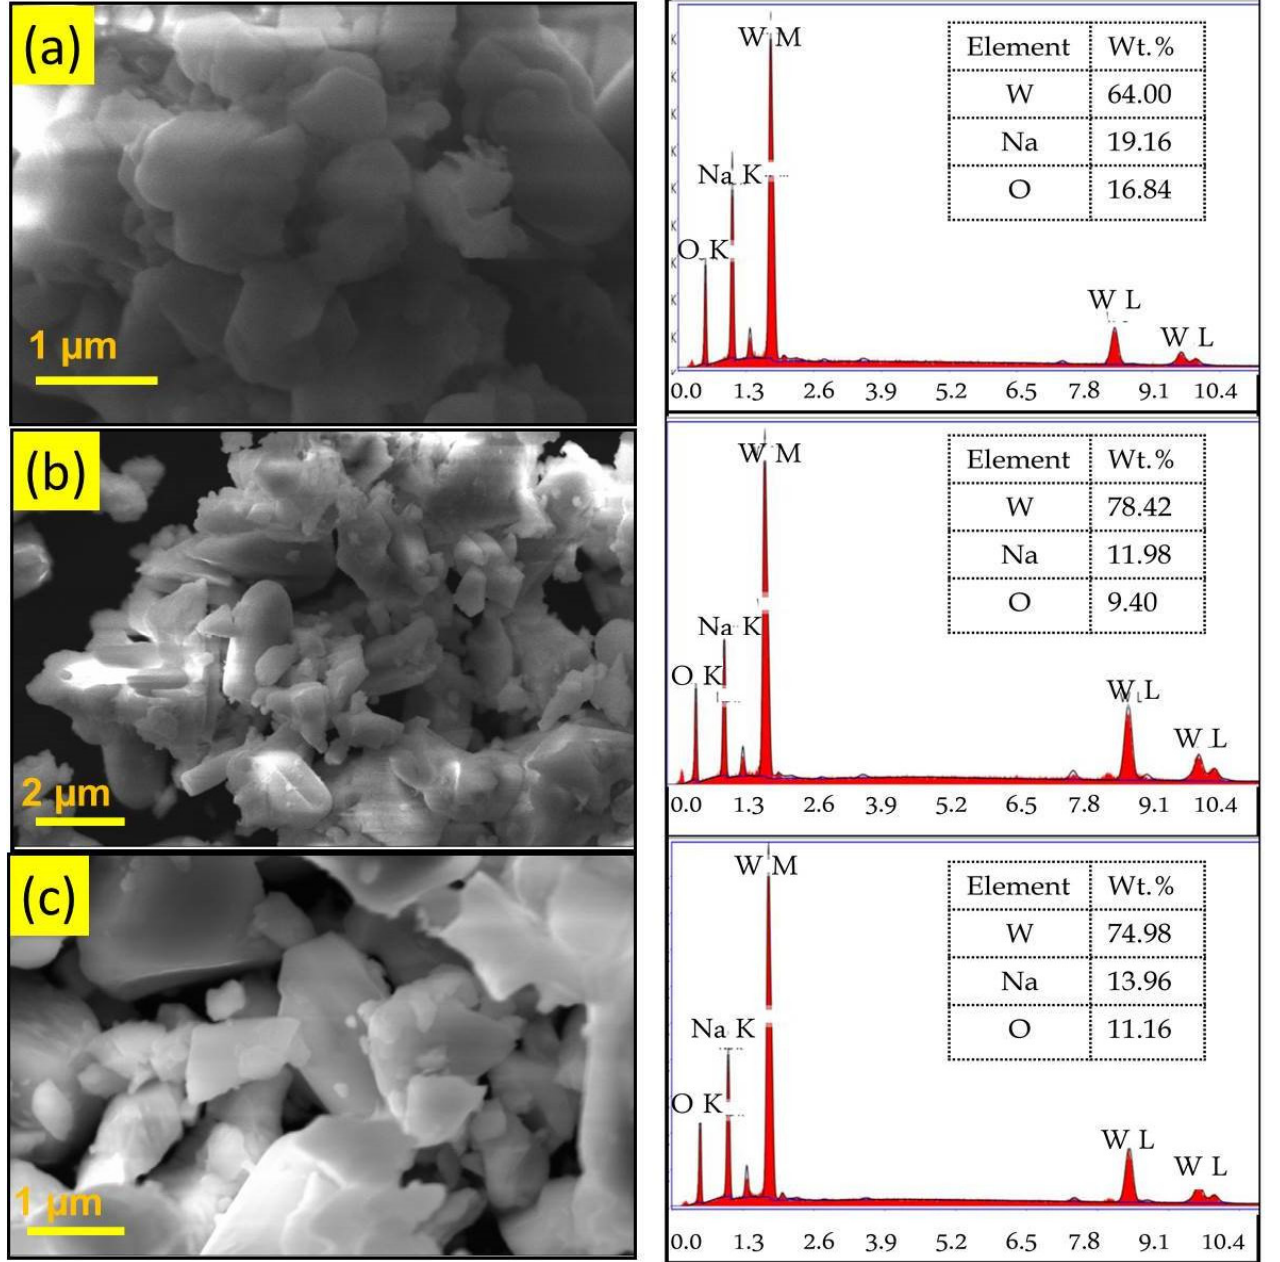
Figure 3. SEM and EDX images of ( a ) phthalic-acid-, ( b ) citric-acid-, and ( c ) oxalic-acid-assisted WO 3 nanoparticles.